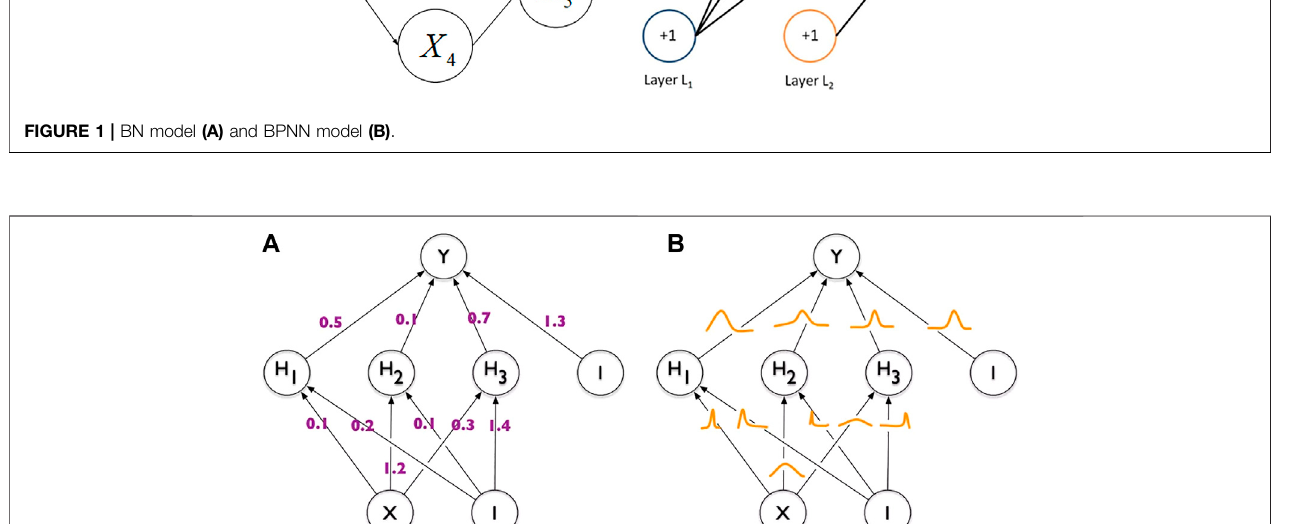
FIGURE 2 | Comparison of neural network (A) and Bayesian neural network (B) .